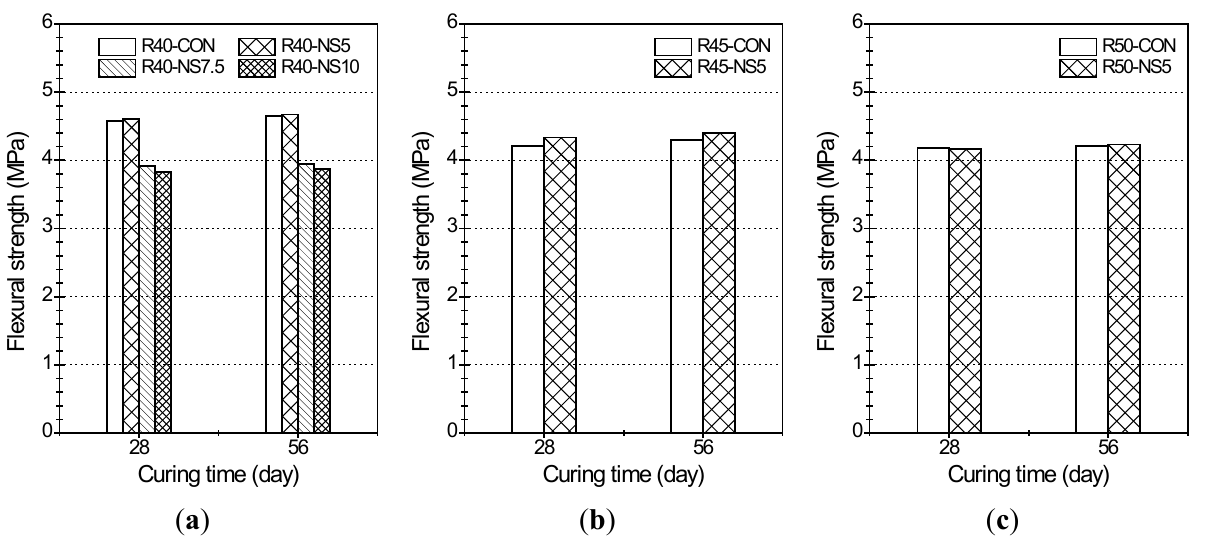
Figure 2. Flexural strength of prism beams with ( a ) W/C of 40%; ( b ) W/C of 45%; and ( c ) W/C of 50% in relation to W/C and curing